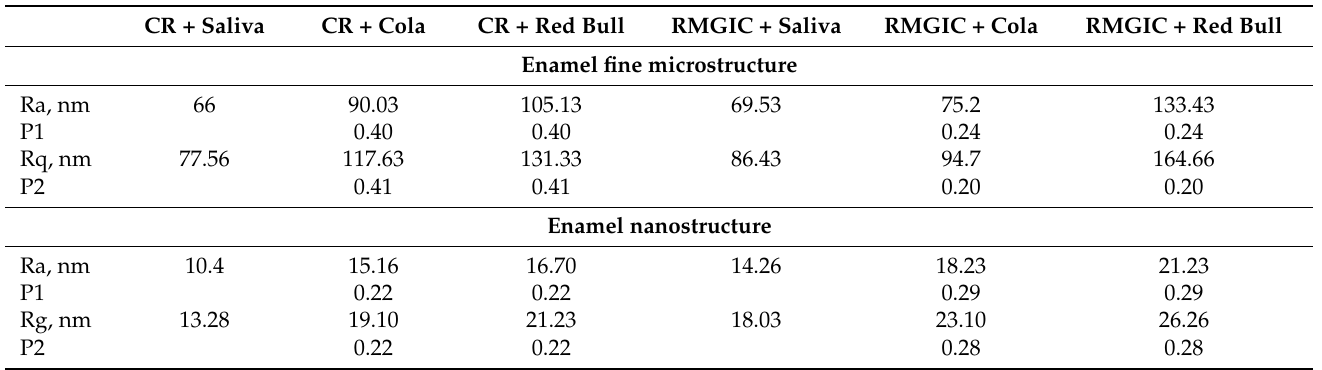
Table 3. Surface roughness statistical analysis for the samples after